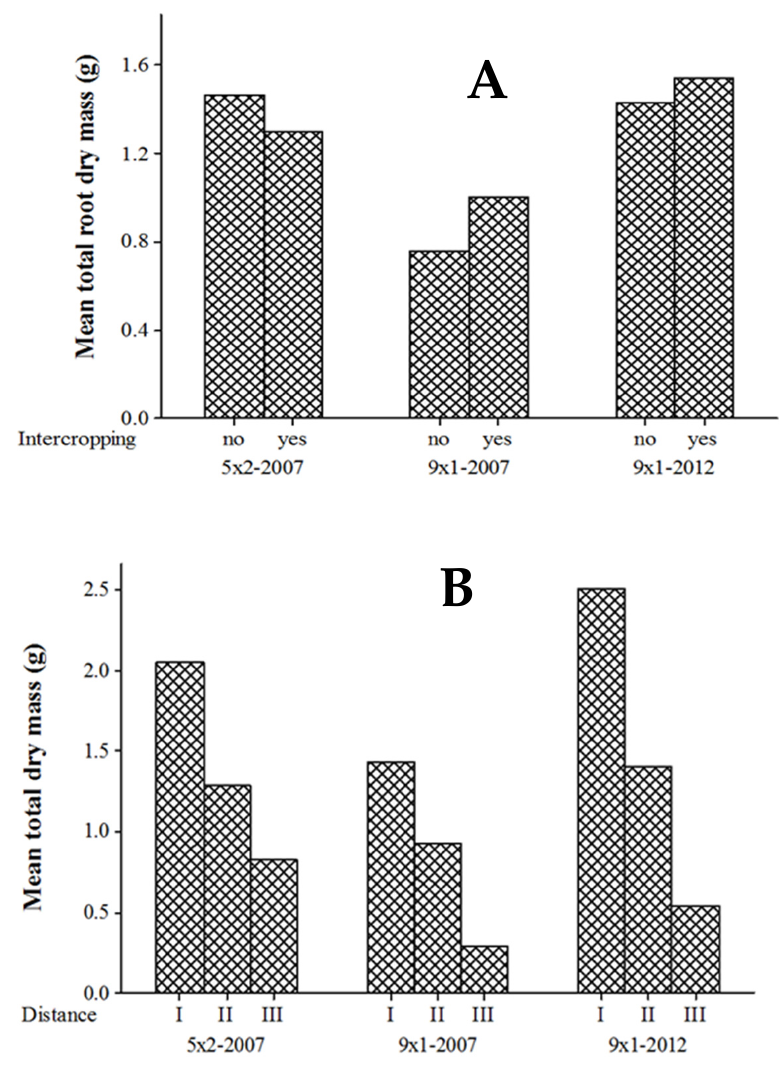
Figure 4. Main effects of intercropping ( A ) and distance ( B ) from the tree on total root dry mass of E. camaldulensis trees in stands established with 5 m × 2 m spacing in 2007 and 9 m × 1 m spacing in 2007 and 2012.